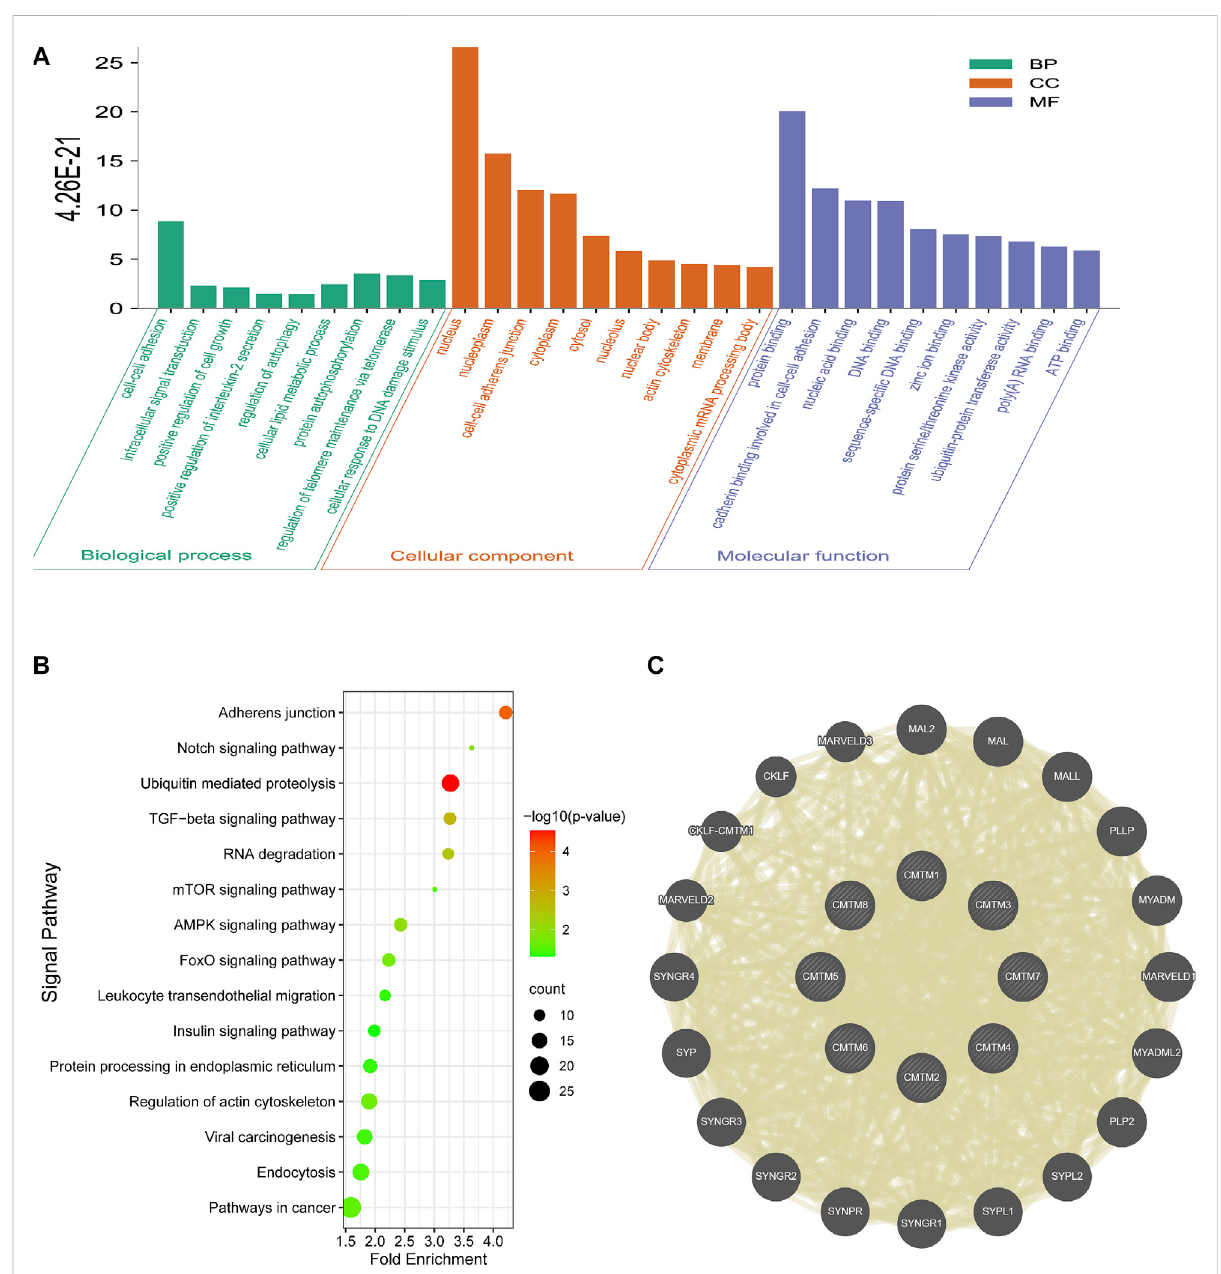
FIGURE 7 Gofunctionannotation,KEGGpathwayenrichmentanalysisandco-expressionanalysisoftheCMTMfamilyinOV. (A) Thethreecomponentsof Go functional annotation: biological processes, cellular components, and molecular functions. (B) Enrichment analysis of KEGG pathway. Enriched pathways included the AMPK signaling pathway, mTOR signaling pathway, Notch signaling pathway, and pathways in cancer. (C) Co-expressed genes of the CMTM family and their interaction